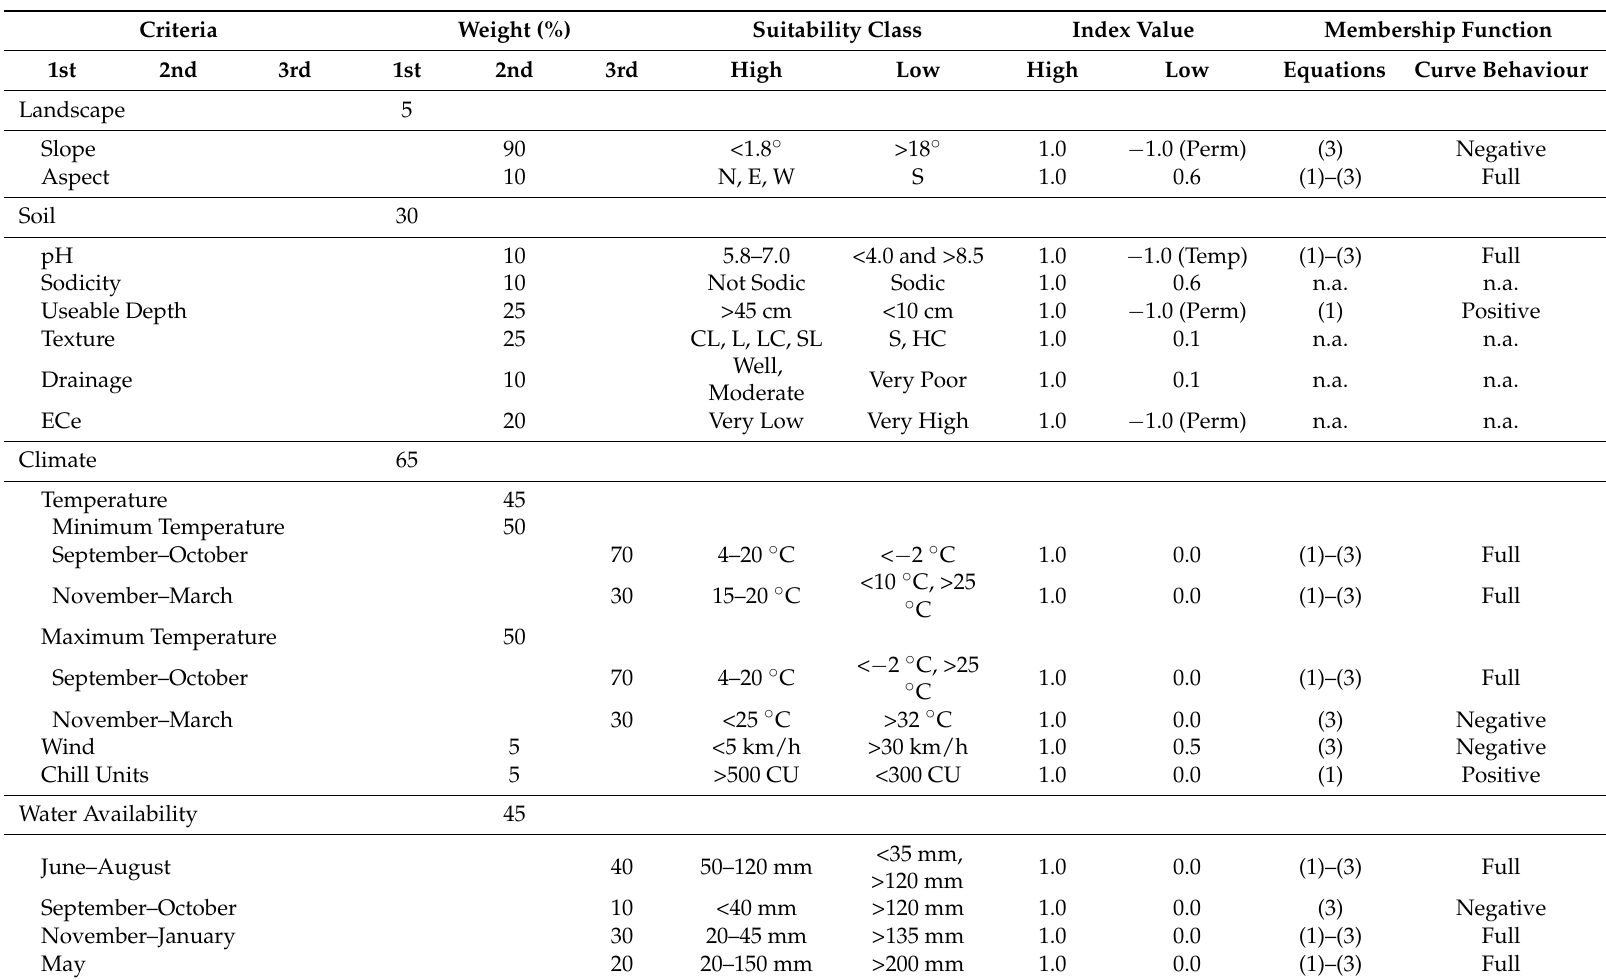
Table 2. Land suitability model for pear